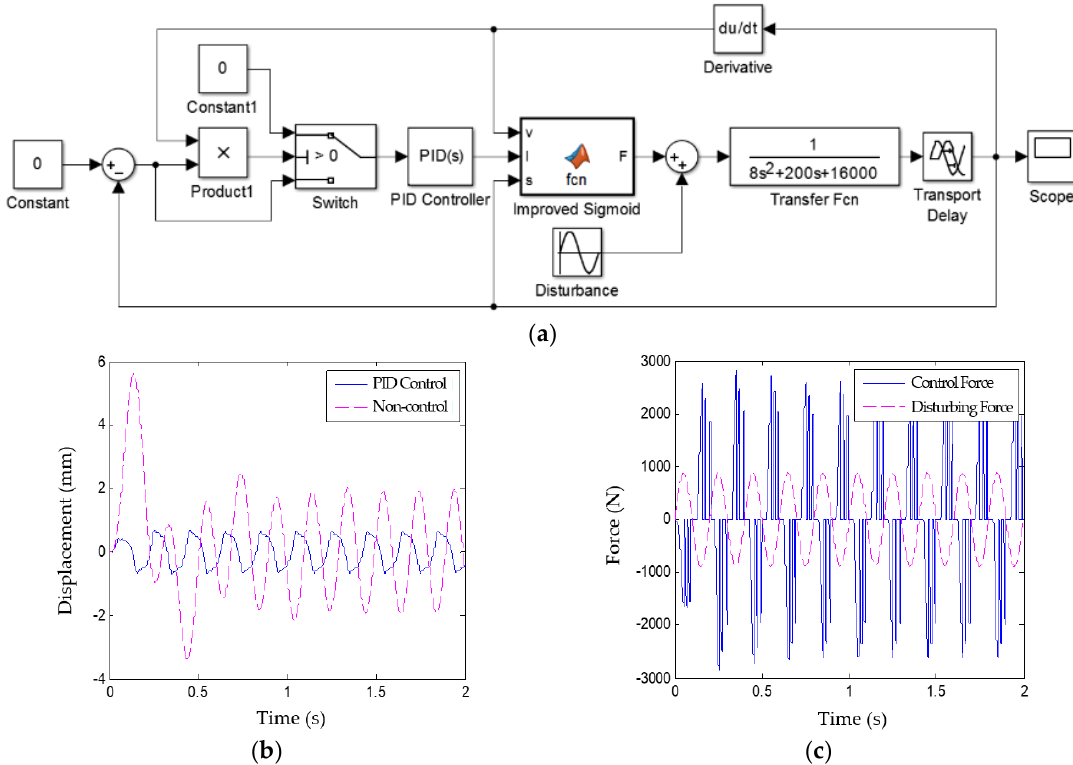
Figure 8. Simulation of PID pipeline vibration control system: ( a ) PID simulation model; ( b ) Vibration displacement response; ( c ) Control force and disturbance dynamics